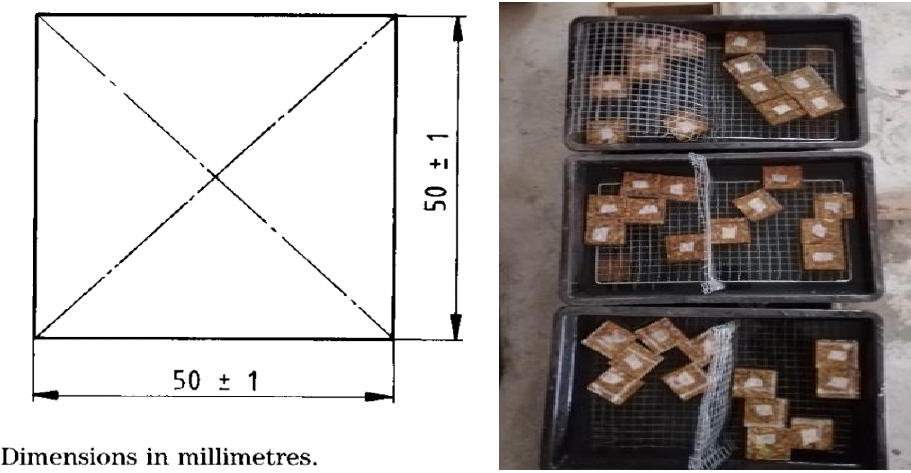
Figure 8. Test piece for the measurement and Test pieces immersed in water for 24 h.